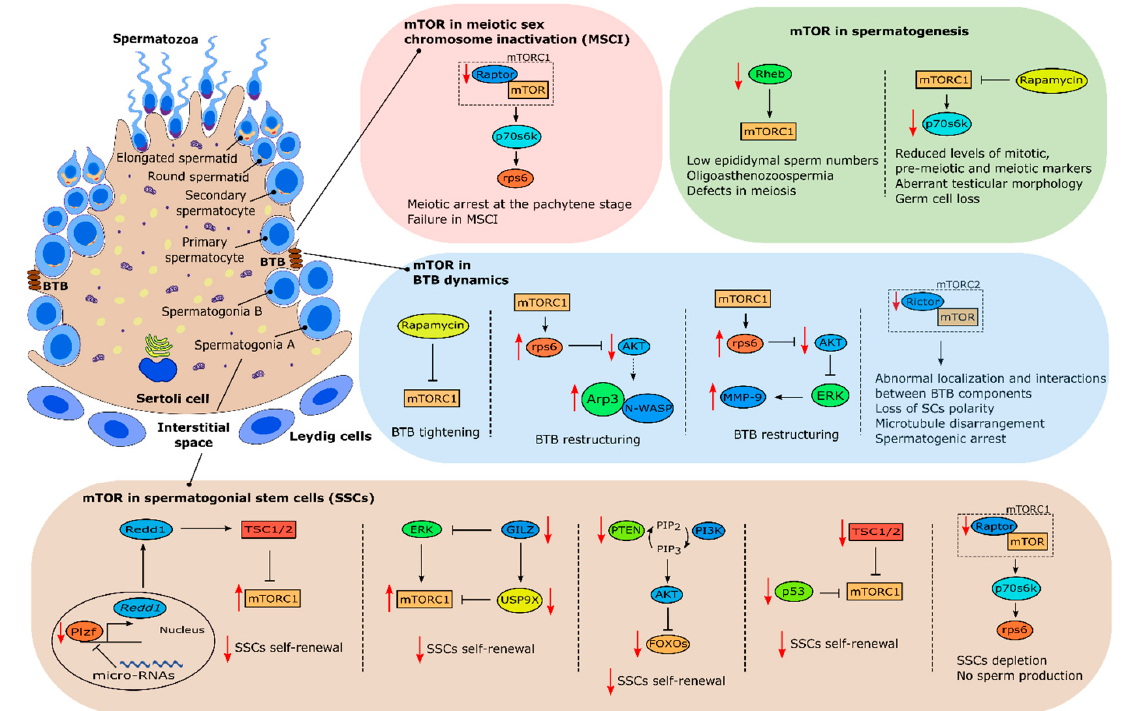
Figure 3. Involvement of mTOR in several processes linked with male fertility. mTORC1 is required